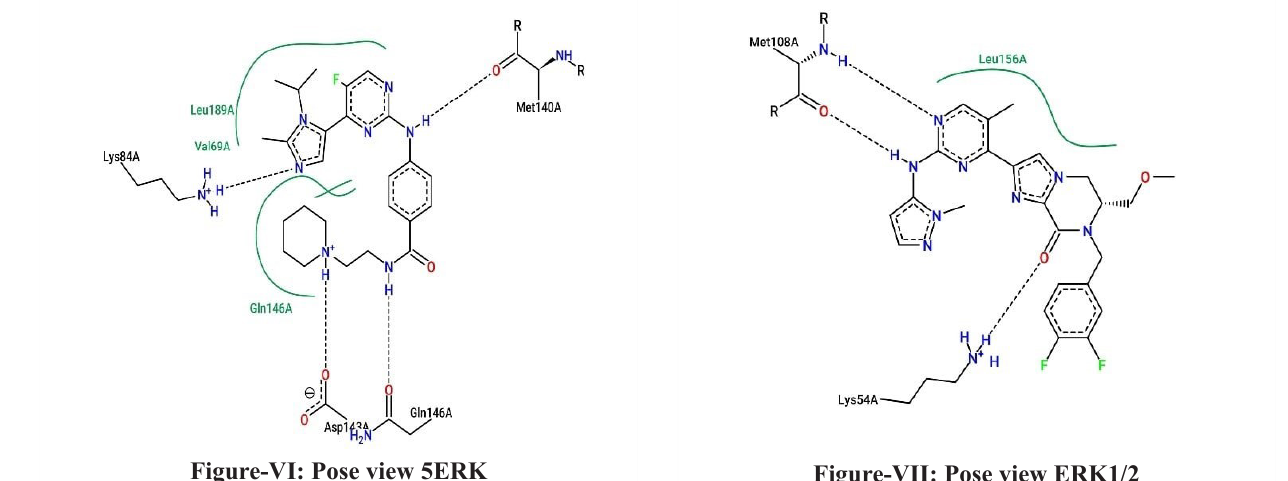
Figure-VII: Pose view